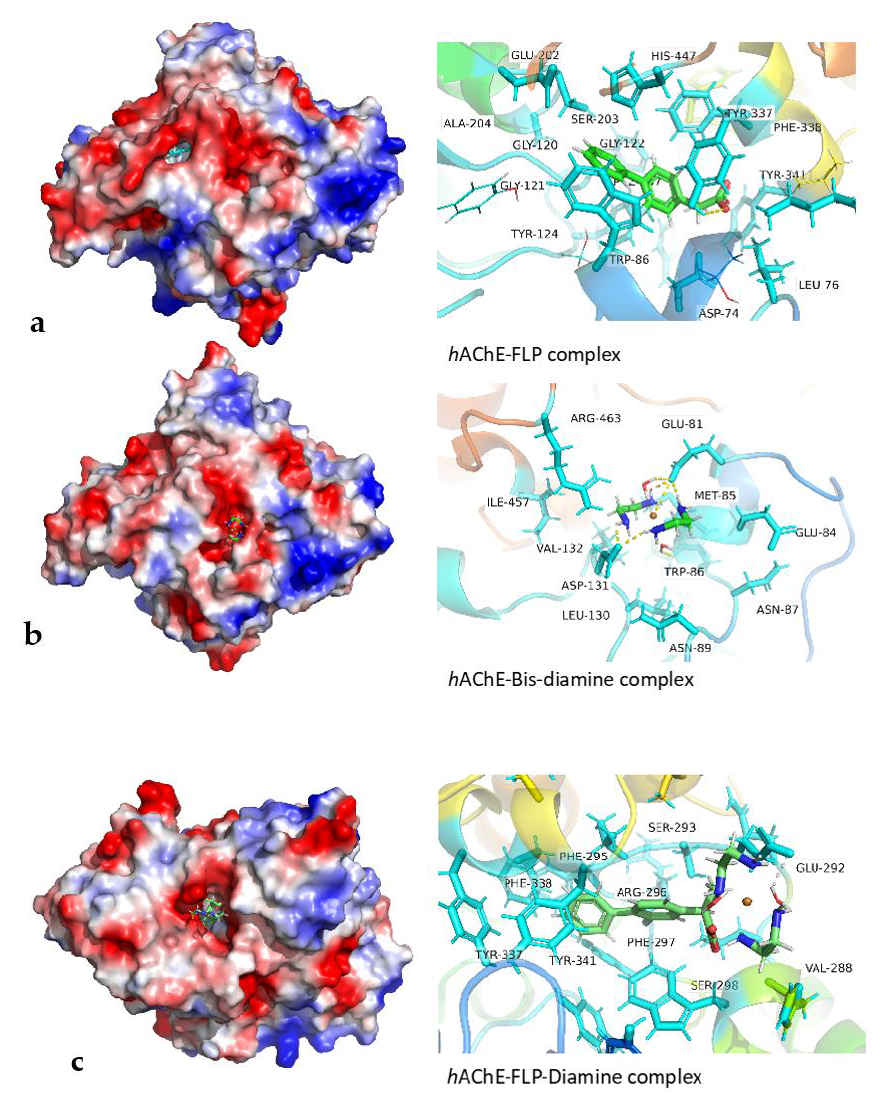
Figure 3. Binding mode of flurbiprofen (FLP) ( a ), bis-diamine metal complex ( b ), FLP-bis-diamine metal complex ( c ) in the catalytic and peripheral pocket of h AChE. The figures on the left show electrostatic potential surface (generated with PyMol) and ligand binding cavities (gorge).